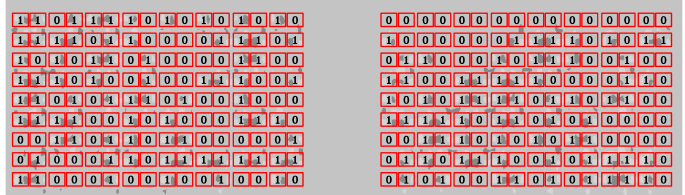
Figure 16: Decoded bit values of a random key. Control bits: 0x0000557b ,